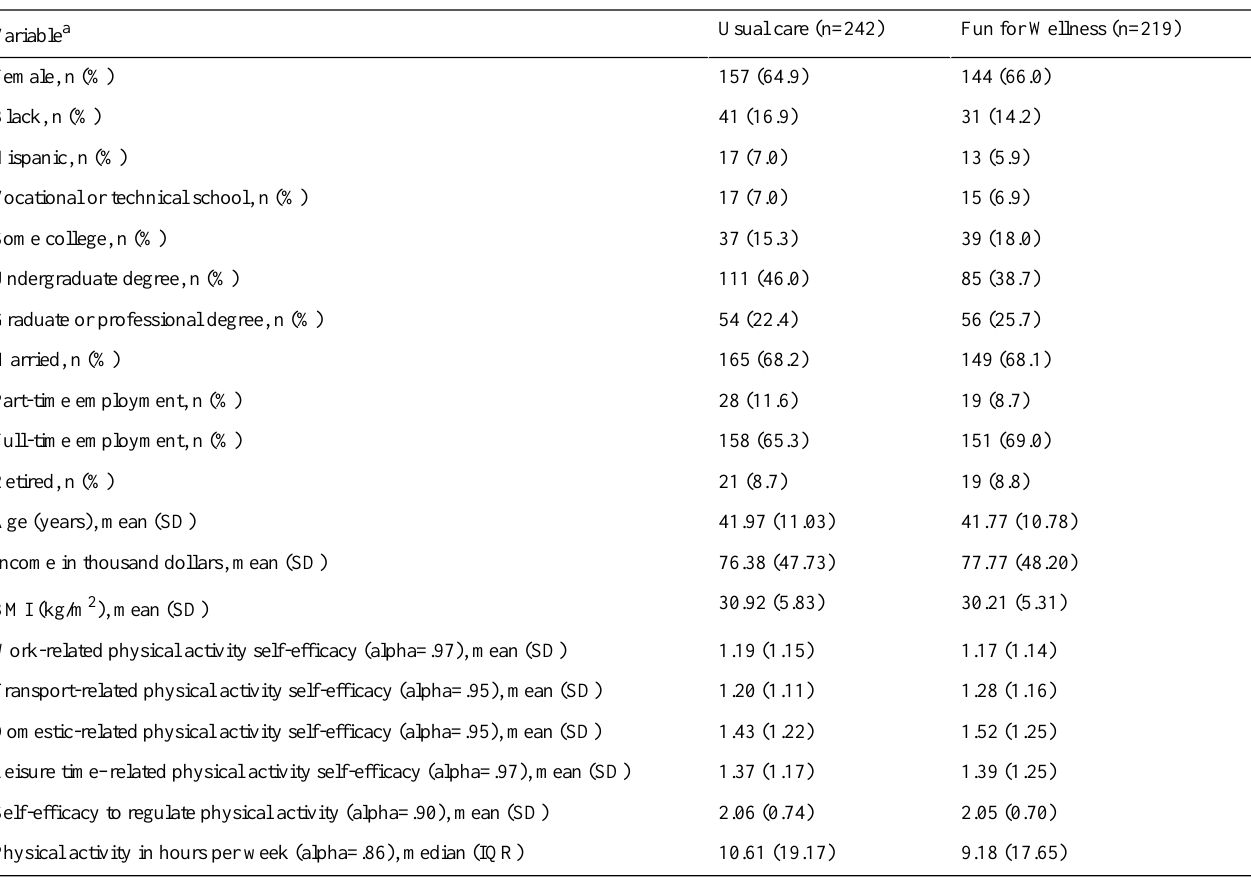
Table 1. Descriptive statistics for demographic characteristics, self-efficacy domain scores, and physical activity scores at baseline for participants by randomization group